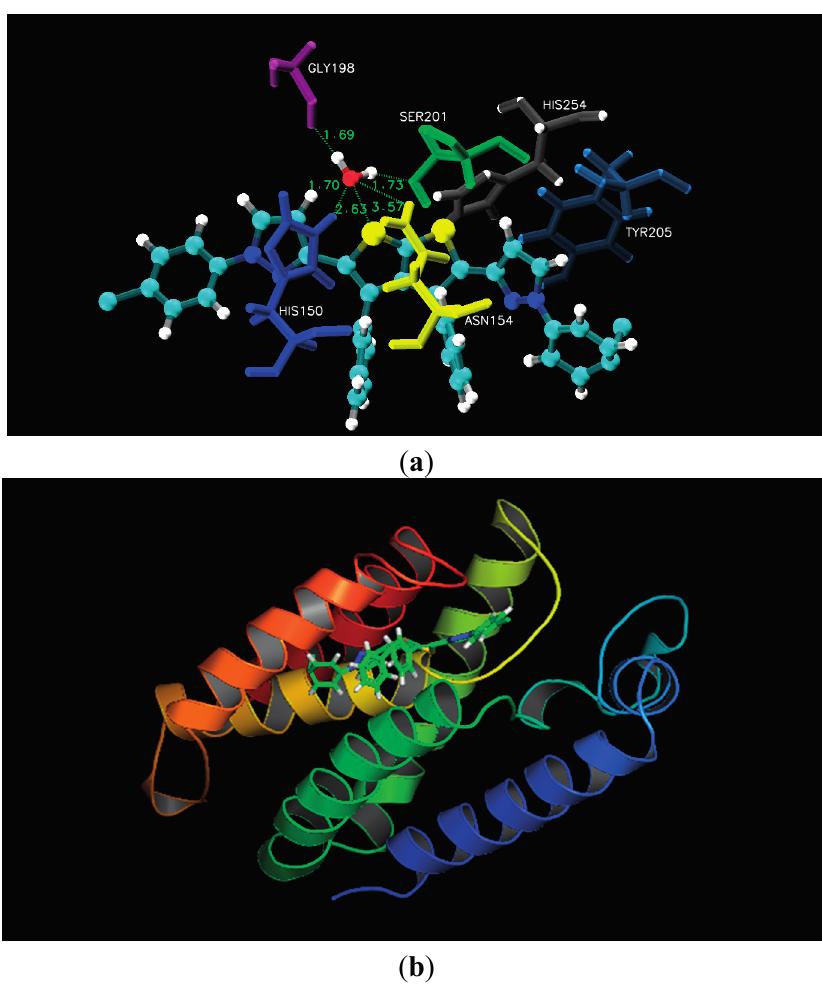
Figure 2. ( a ) Molecular docking interaction model for the most potent anti-bacterial compound 2b with rhomboid protease of E. coli (PDB ID.3ZMI) showing hydrogen bonding through conserved water molecule & hydrophobic interactions; ( b ) ribbon diagram of rhomboid protease ( E. coli ) complex with inhibitor 2b